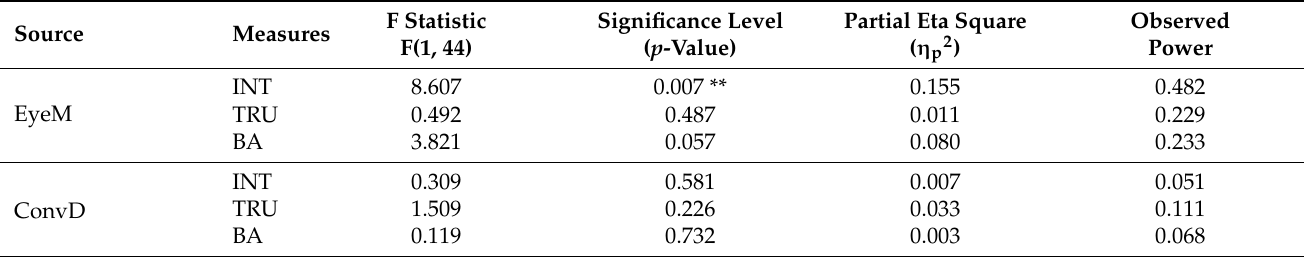
Table A12. Tests of Within-Subjects Effects for Public Shuttle Scenario (N =